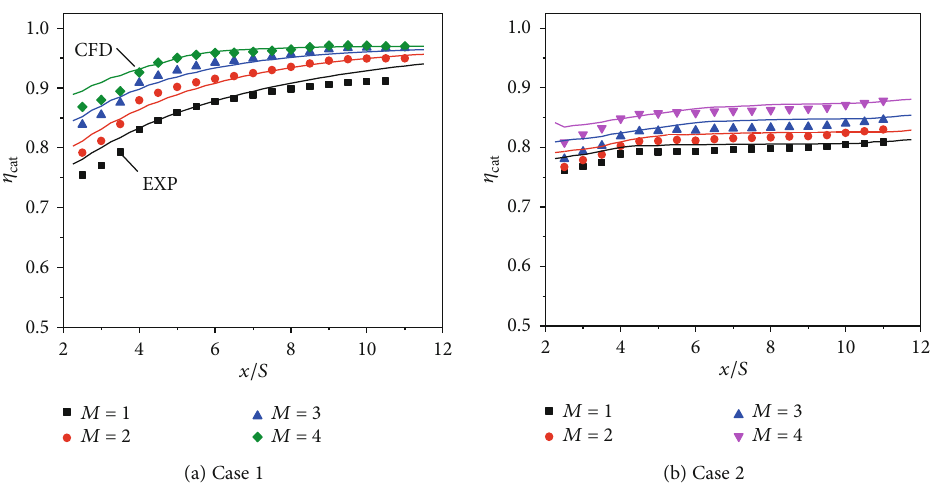
Figure 9: Comparison of the centerline averaged overall cooling e ff ectiveness.